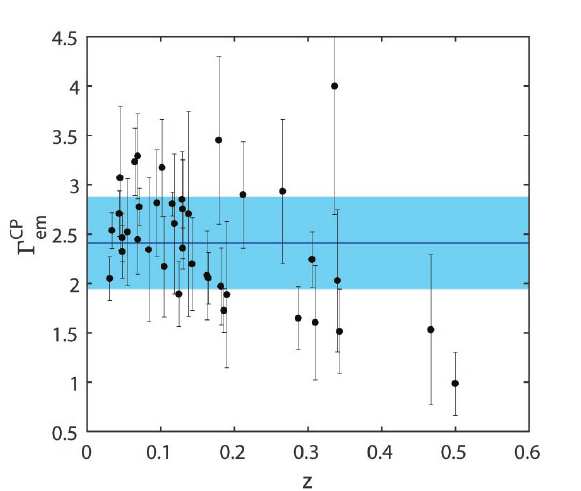
Figure 11. Horizontal fitting straight line in conventional physics. The values of Γ CP em with the corresponding error bars are plotted versus z for all blazars belonging to S . Superimposed is the = 2.37. The light blue strip encompasses horizontal straight regression line Γ CP em = 2.41 with χ 2 red,CP 95% of the sources and its total width is 0.94, which equals 39% of the mean value Γ CP em = 2.41. (Credit [118]).